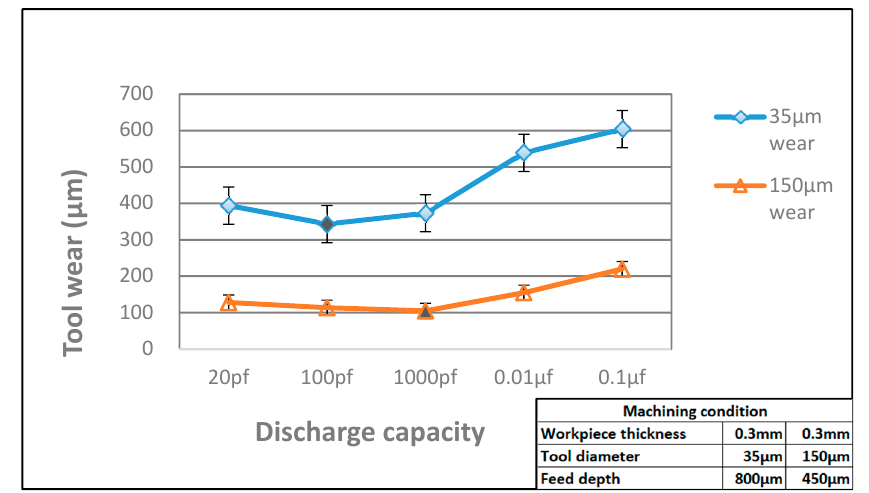
Figure 12. Tool wear in micro-hole drilling of WC-Co.